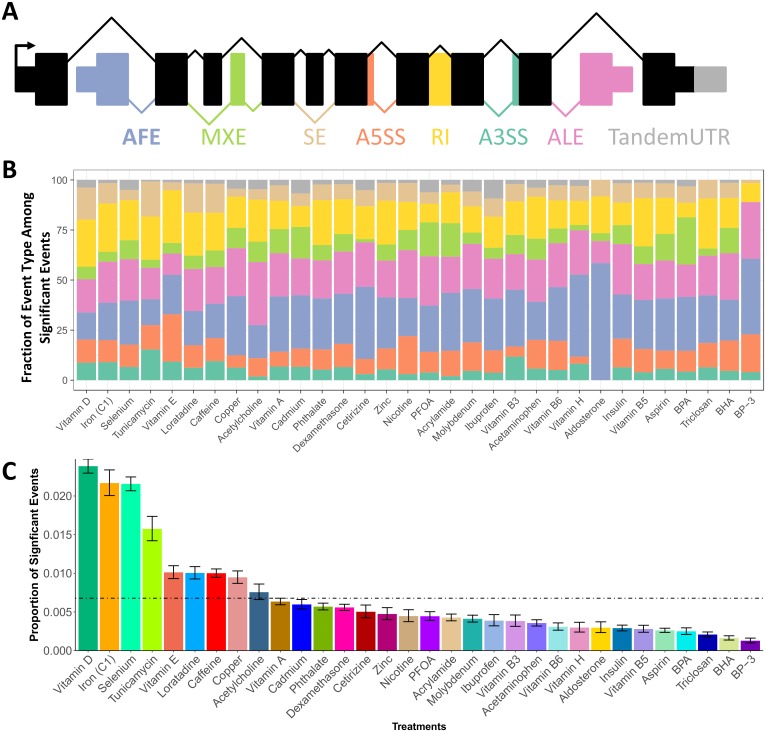
RNA processing events and gene expression changes following treatment.A) Diagram depicting the 8 types of RNA splicing changes characterized in this work: alternative first exon, mutually exclusive exon, skipped exon, alternative 5’ splice site, retained intron, alternative 3’ splice site, alternative last exon, and tandem untranslated region. B) Graph showing the estimated proportion of each event type within a given treatment resulting from a logistic model. C) Proportion of significant changes in events over the total number of events that were tested in that treatment. Each bar combines all cell types treated with the compound. Error bars denote the standard error from a binomial test. The dotted line indicates the average proportion of significant events across all treatments.